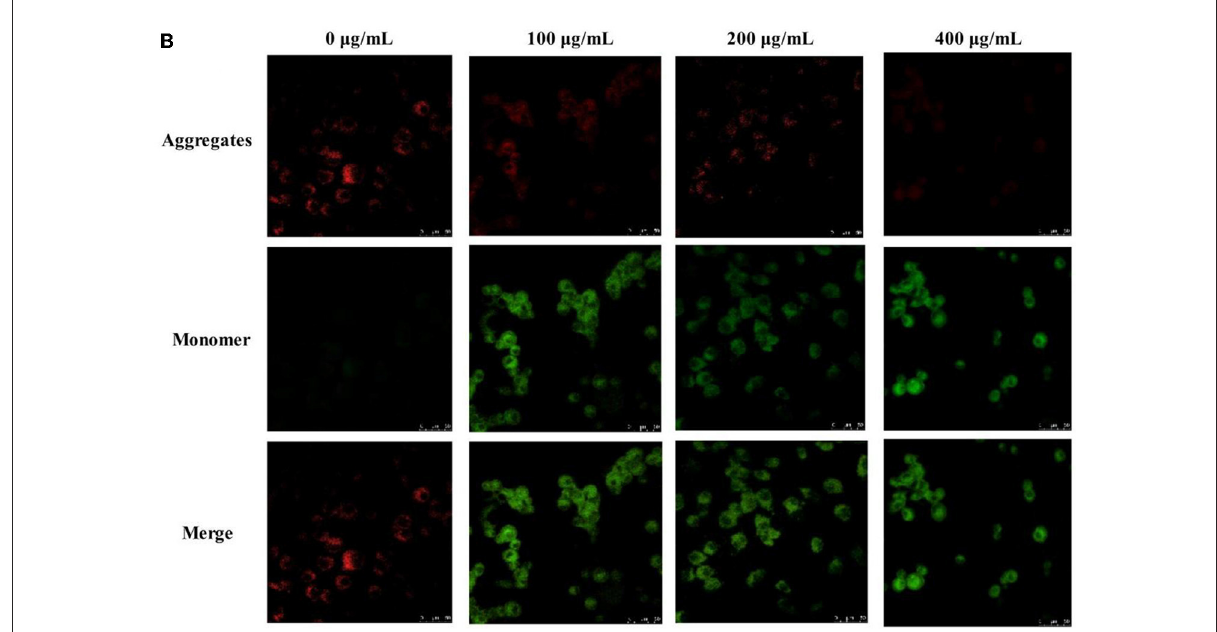
FIGURE5 The morphological changes of HepG2 cells treated with 0, 100, 200, and 400 µ g/mL of PSP-1 for 72h (A) , the morphological characterization of HepG2 cells was observed and photographed under a Confocal laser scanning microscope (A1) , nuclear morphological changes induced by PSP-1 in HepG2 cells after DAPI staining. (A2) Effect of PSP-1 on MMP (B) Cell cycle progression was assessed using propidium iodide staining detected by fluorescence activated cell sorting. (C) The apoptotic rates of the indicated cells induced by PSP-1 at different concentrations for 72h were detected by ANNexin V/PI double-staining asssy (D)